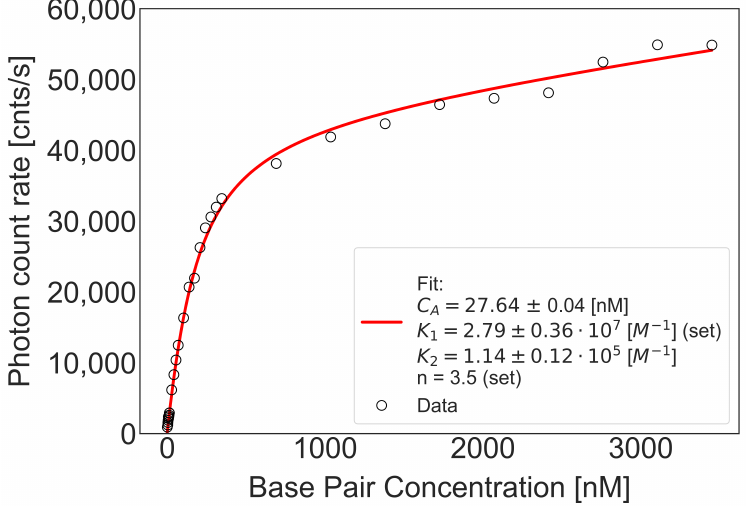
Figure 4. Equilibrium constant determination of YOYO-1–DNA (69 bp) complex formation. Black circles represent data points (countrate acquired for various DNA concentrations added to 20 nM YOYO-1 in titration experiment), red line correspond to fit of Equation (7). Fitting includes inter- actions for both intercalation models. C A is a fitted value of dye initial concentration, K 1 and K 2 are equilibrium constants for mono-intercalation and bis-intercalation, respectively, n is a size of a binding site (see Supplementary Materials, section Size of the binding